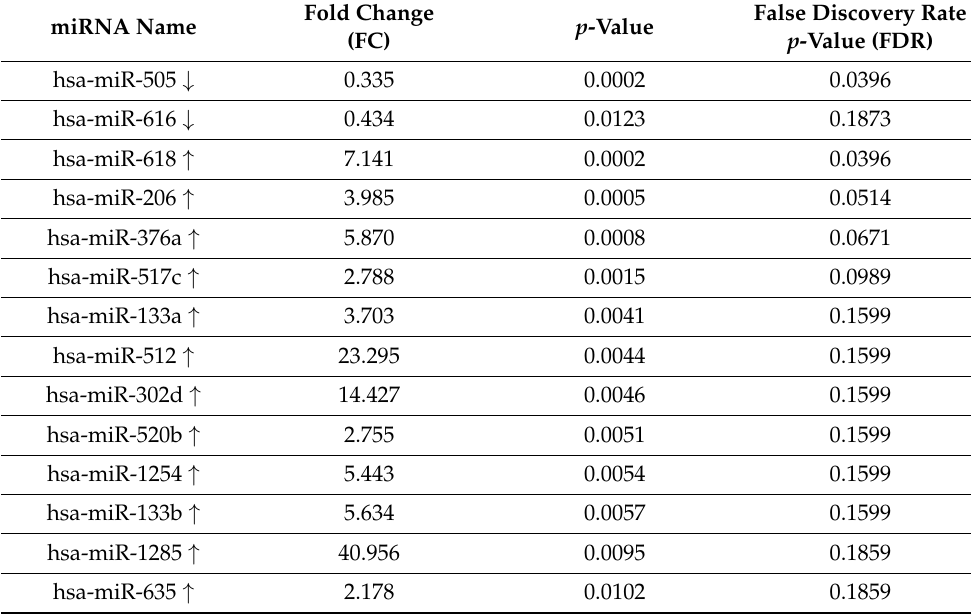
Figure 2. Volcano plot showing differentially expressed miRNAs between OB and NW women. The graph reports the 334 detectable miRNAs (all black and red dots). The horizontal line states the –log 10 of the p -value 0.05; the two vertical lines indicate the log 2 of the FC values 0.5 and 2.0. As a result, miRNAs with a significantly different expression vs. NW are displayed in red ( n = 31). In particular, the upper left quadrant reports the downregulated miRNAs, while the upper right one all the upregulated miRNAs. Table 4. Upregulated and downregulated miRNAs in maternal